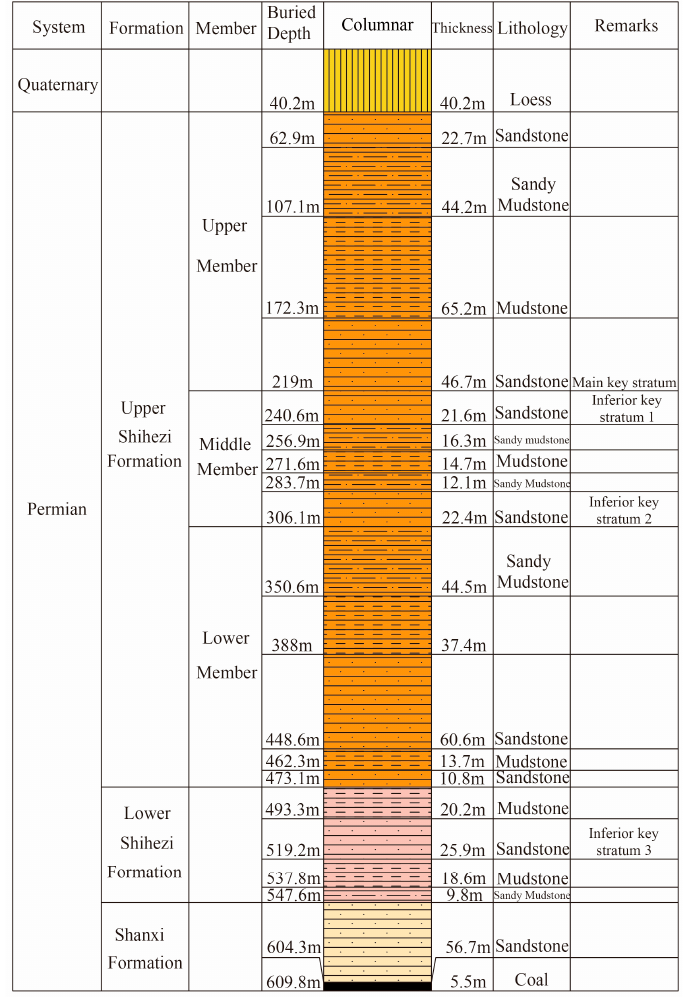
Figure 2. Comprehensive column section.